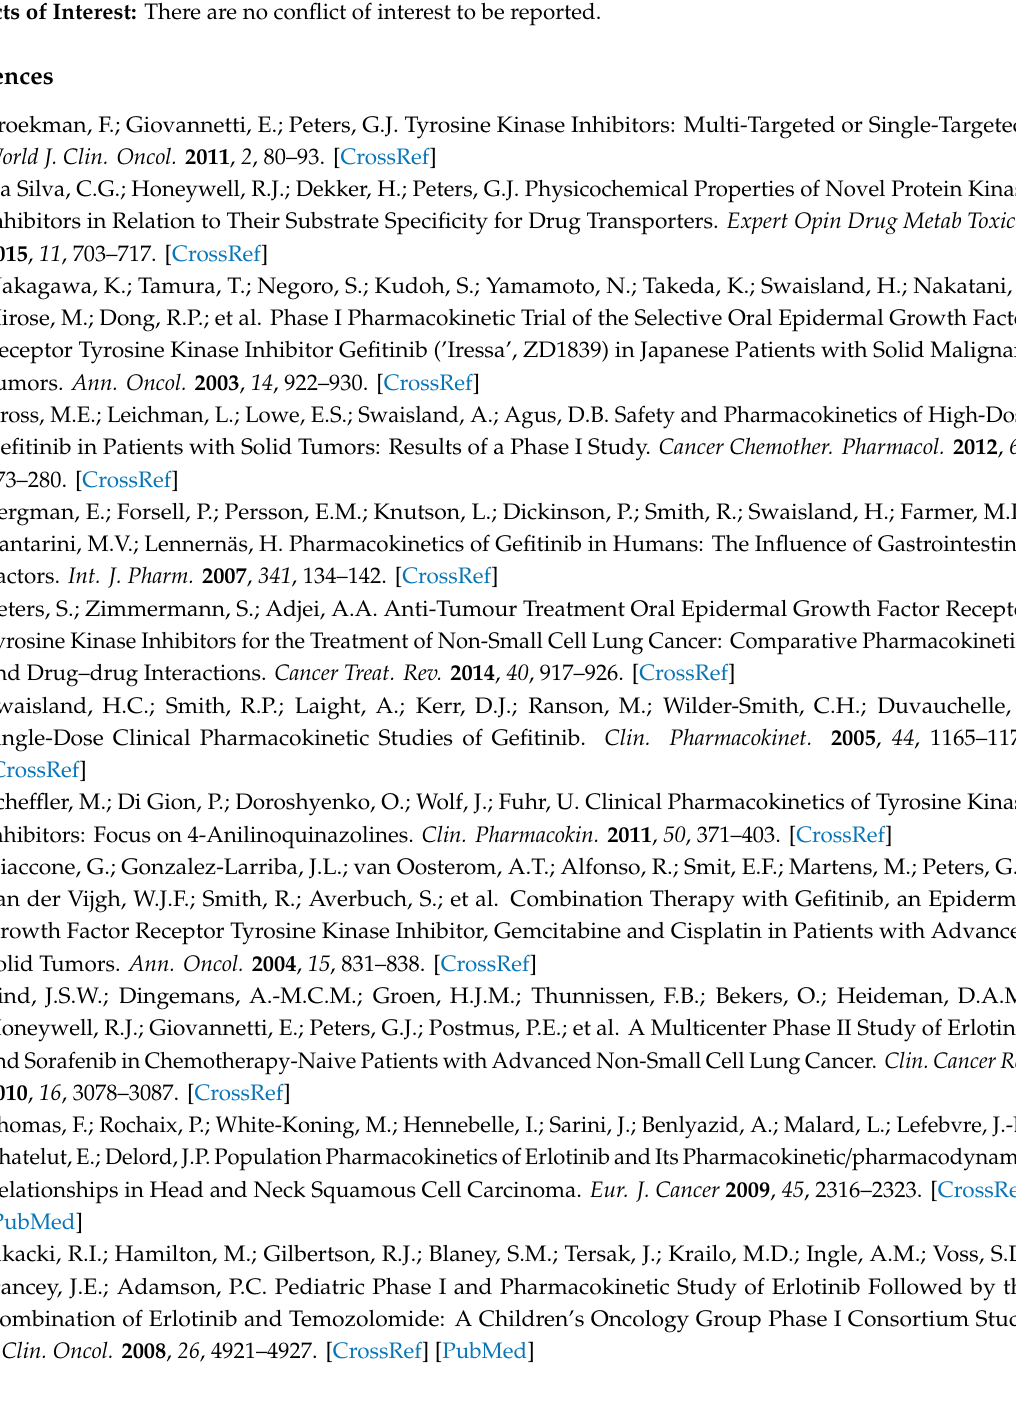
Figure S1: Schematic representation of the CaCo2 Transwell system, Figure S2: Accumulation of crizotinib and sunitinib in MCF / MR breast cancer cells and T98 and U251 glioma cells; e ff ect of